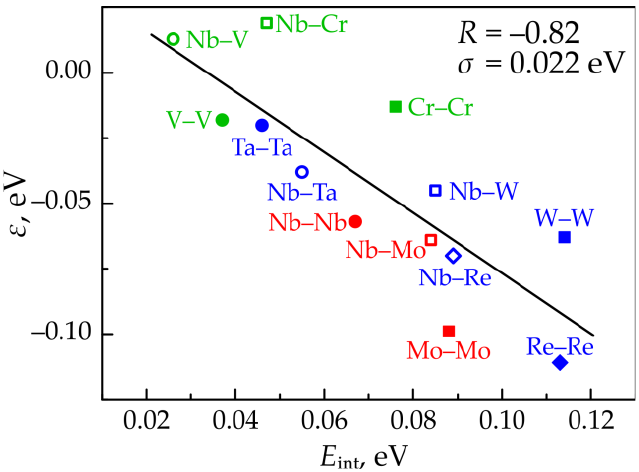
Figure 10. Correlation between ε and the interaction energy between impurity atoms in the pres- ence of oxygen. The solid lines are obtained by the least-squares method.